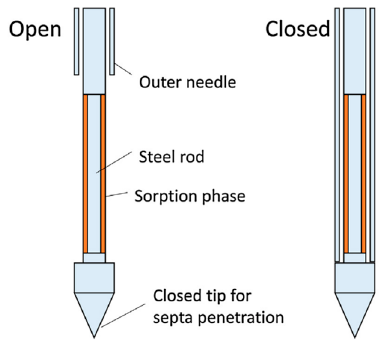
Figure 2. The Arrow SPME system with sorbent exposed (left) and with sorbent covered by a steel tube (right) [6].